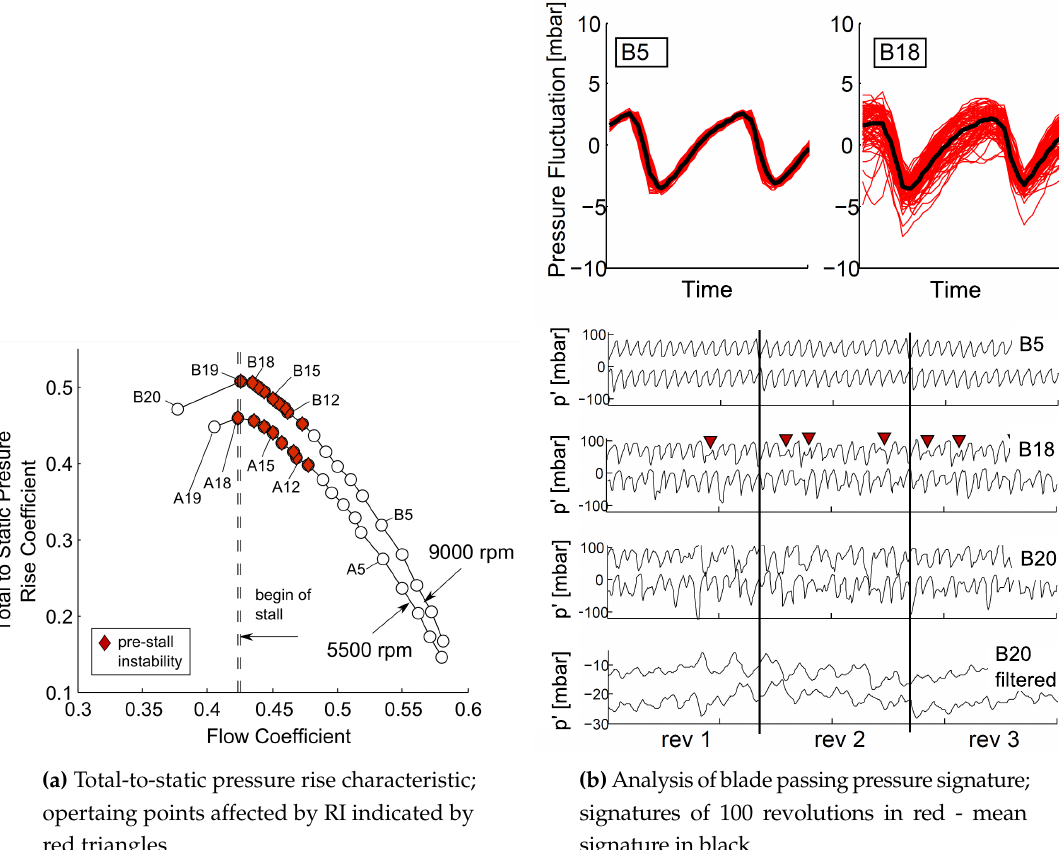
Figure 3. Compressor performance